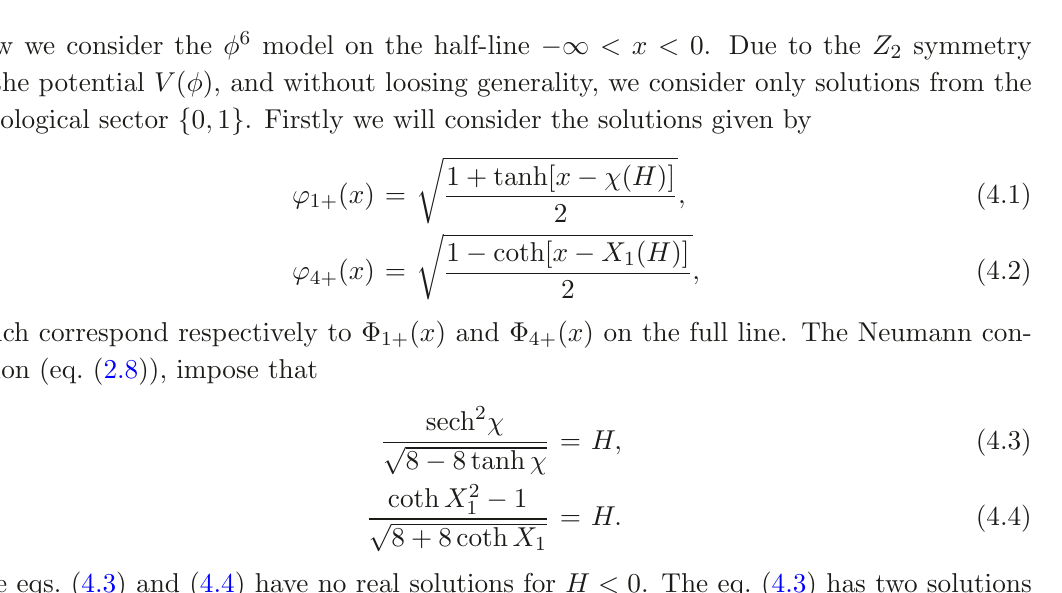
a ) + Φ 2+ ( x + a )) and b) − a ) + Φ 2+ ( x + a ) 1). Here we considered a = − −